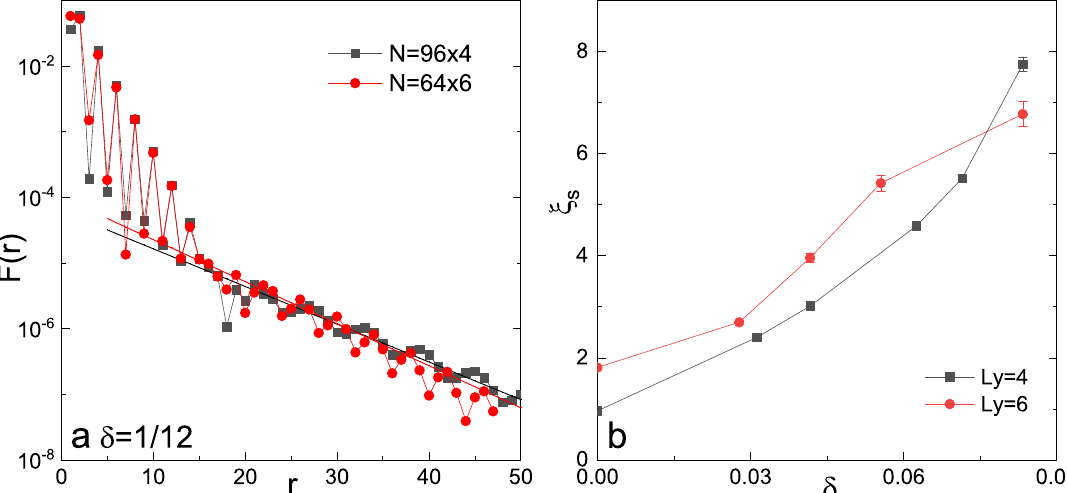
Fig. 5 Spin – spin correlations. a Examples of spin – spin correlation functions F ( r ) at doping level δ = 1/12 for L y = 4 and L y = 6 cylinders on the semi-logarithmic scale. Solid lines denote exponential fi tting F ð r Þ (cid:1) e (cid:3) r = ξ s , where r is the distance between two sites in the e x direction. b The spin – spin correlation length ξ s as a function of δ for both L y = 4 and L y = 6 cylinders. Error bars denote the numerical